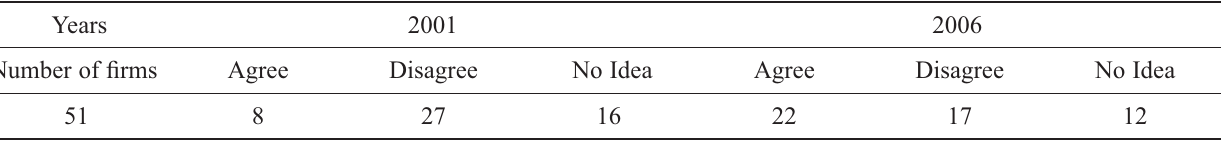
Table 11. Statement 2: “In general, interpretations of regulations affecting my fi rm are consistent and predictable”